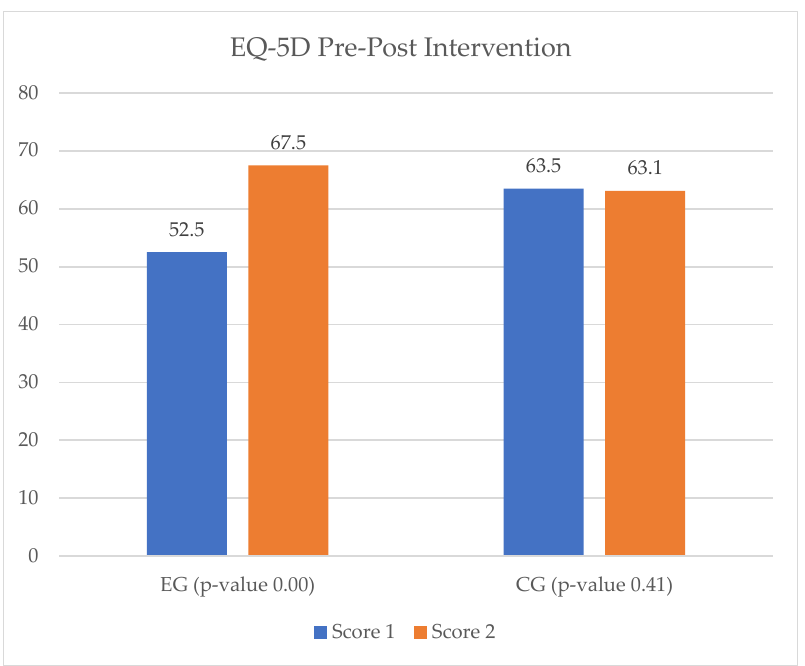
Figure 14. EQ-VAS results for the ischemic heart disease study group.